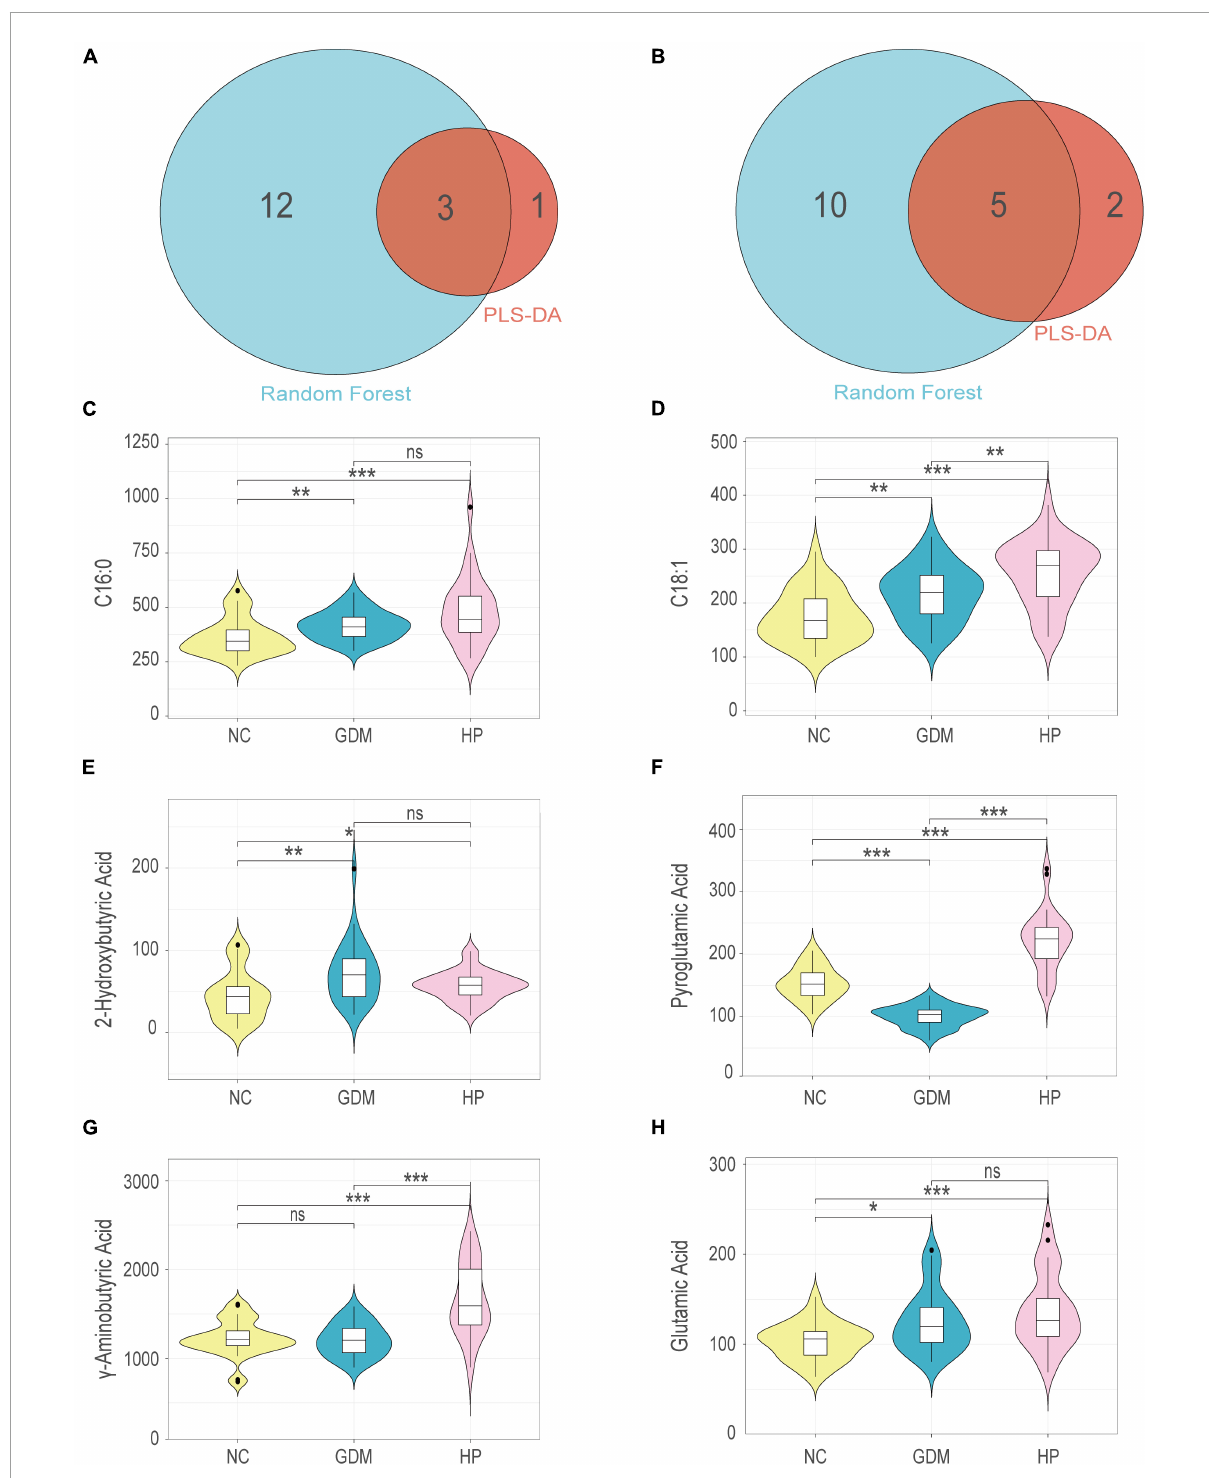
FIGURE4 Venn diagram for shared and distinct metabolites screened out via basic discriminant analysis and random forest analysis within NC-GDM (A) and NC-HP (B) . Univariate analysis for each comparison for: (C) C16:0; (D) C18:1; (E) 2-Hydroxybutyric acid; (F) Pyroglutamic acid; (G) γ -aminobutyric acid; (H) Glutamic acid. *, **, and *** for p < 0.05, p < 0.01, and p < 0.001, respectively; ns, no significant